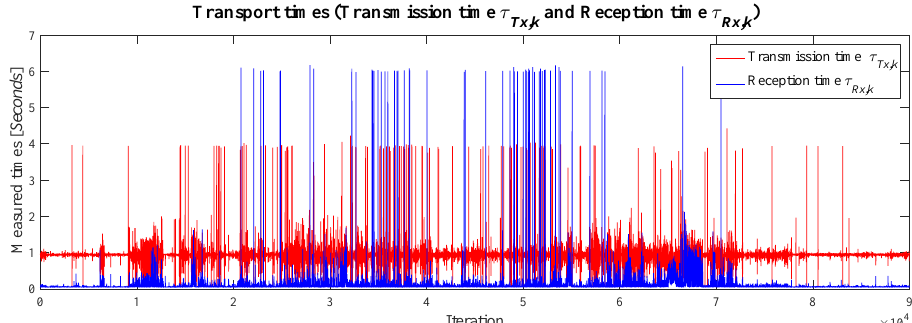
Figure 8. Reception times τ Rx , k and transmission times τ Tx , k using the TCP protocol measured by the